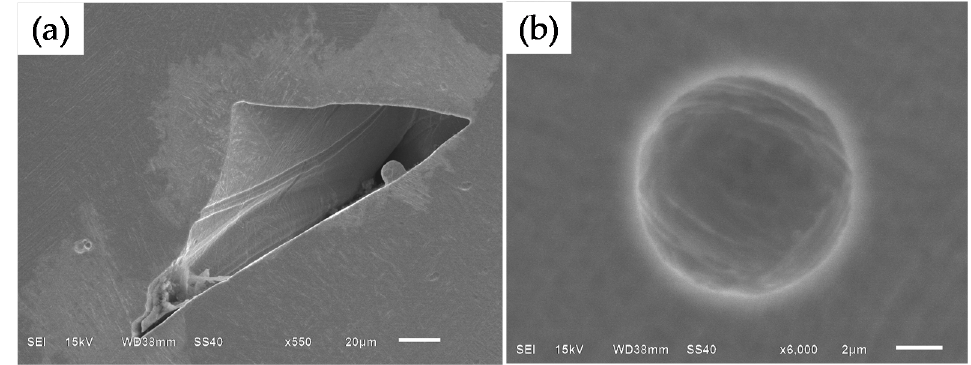
Figure 8. SEM micrographs show the two different defects morphologies; ( a ) large irregular defects; ( b ) small spherical micropore. ( P = 400 W, δ = 200 μ m).